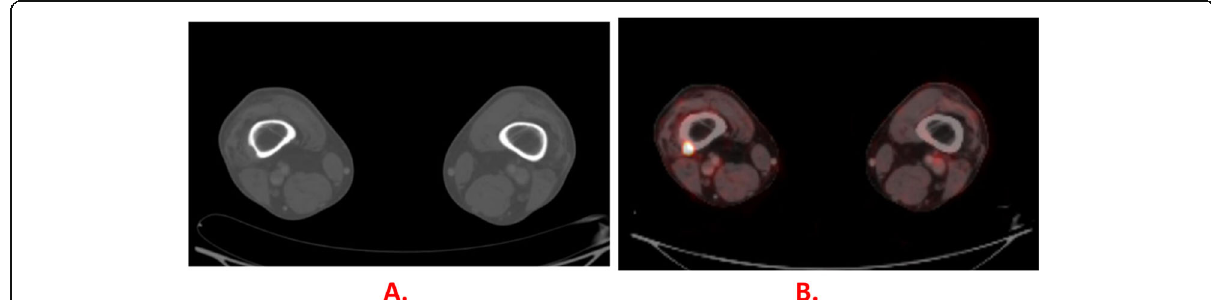
Fig. 4 A 58-year-old male patient, pathologically proven having NSCLC, the initial staging of the patient revealed the following: a CECT staged the patient as M0 without any distant metastasis and b PET/CT upstaged the patient to M1b after detection of an osseous lesion in the outer cortex of the right femur metaphysis that showed high FDG uptake (SUV = 28) with an FDG avid soft tissue